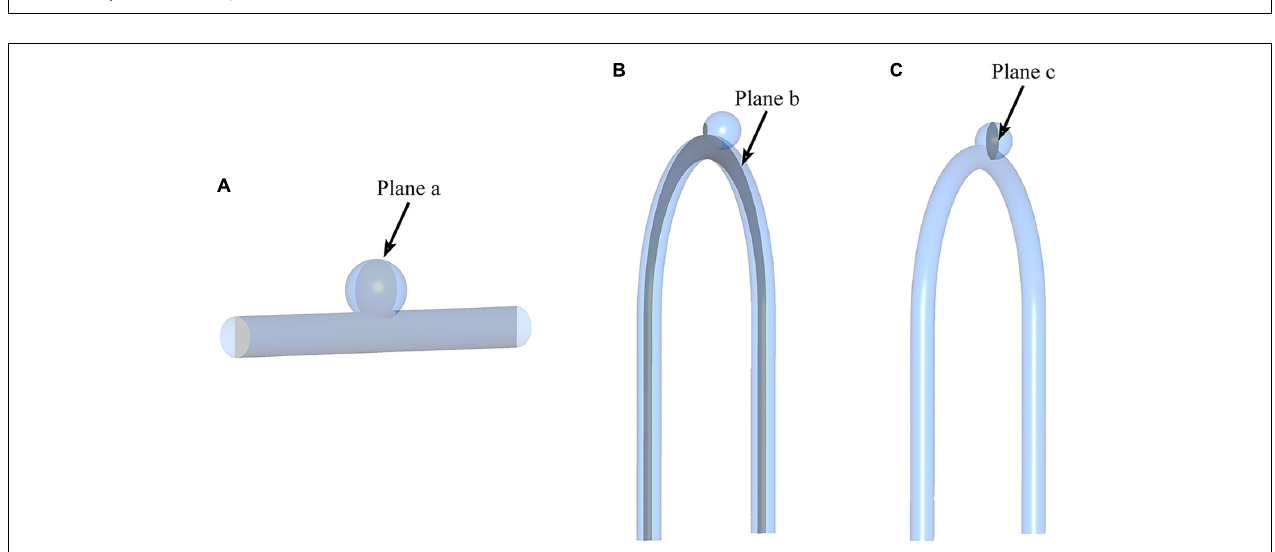
FIGURE 4 | Sketch of measurement planes. For Type 2 models, use a sample with an LA of 30 ◦ . The results shown in Figures 5 , 6 are the velocity and pressure distribution on the section shown in positions (A–C) . (A) Type 1 model symmetry plane; (B) Type 2 model parent artery symmetry plane; (C) Type 2 model aneurysm cross